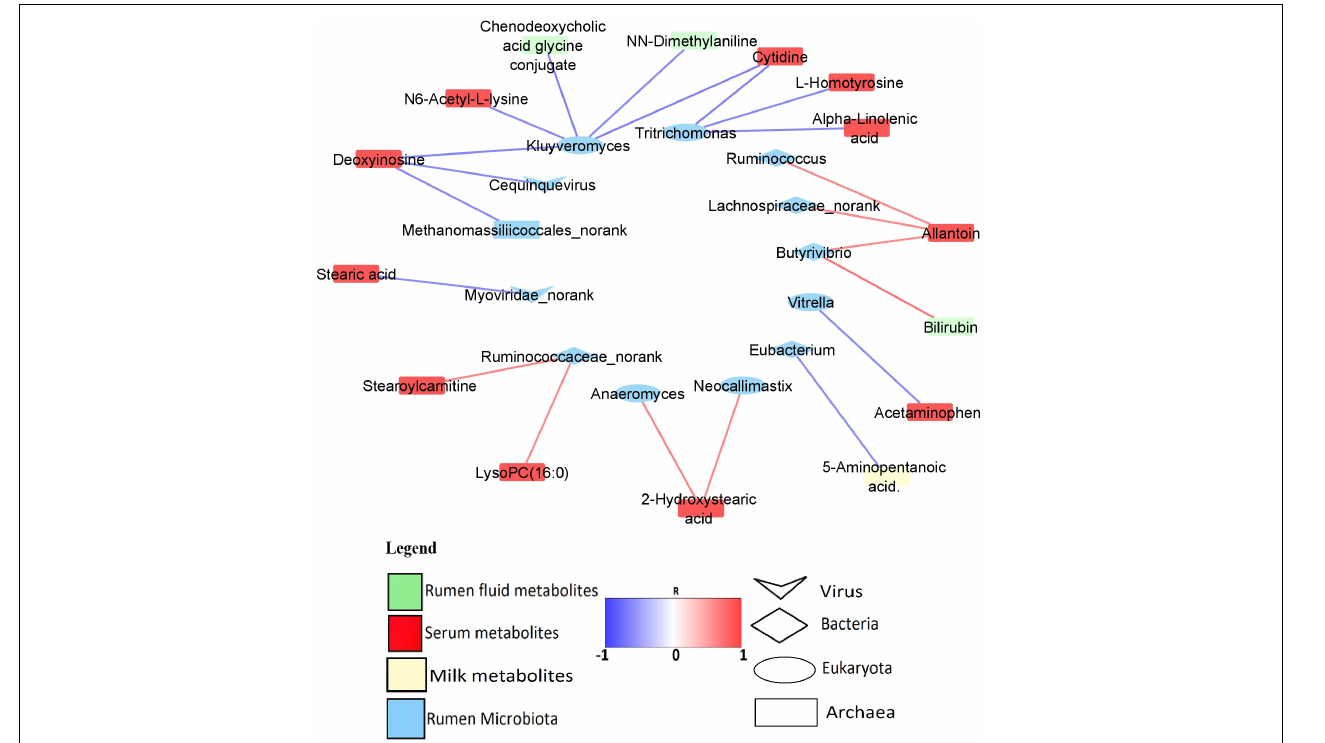
FIGURE 6 | Network of significant correlation ( R > 0.6/ R < –0.6, P < 0.05) between the predominant rumen microbiota and